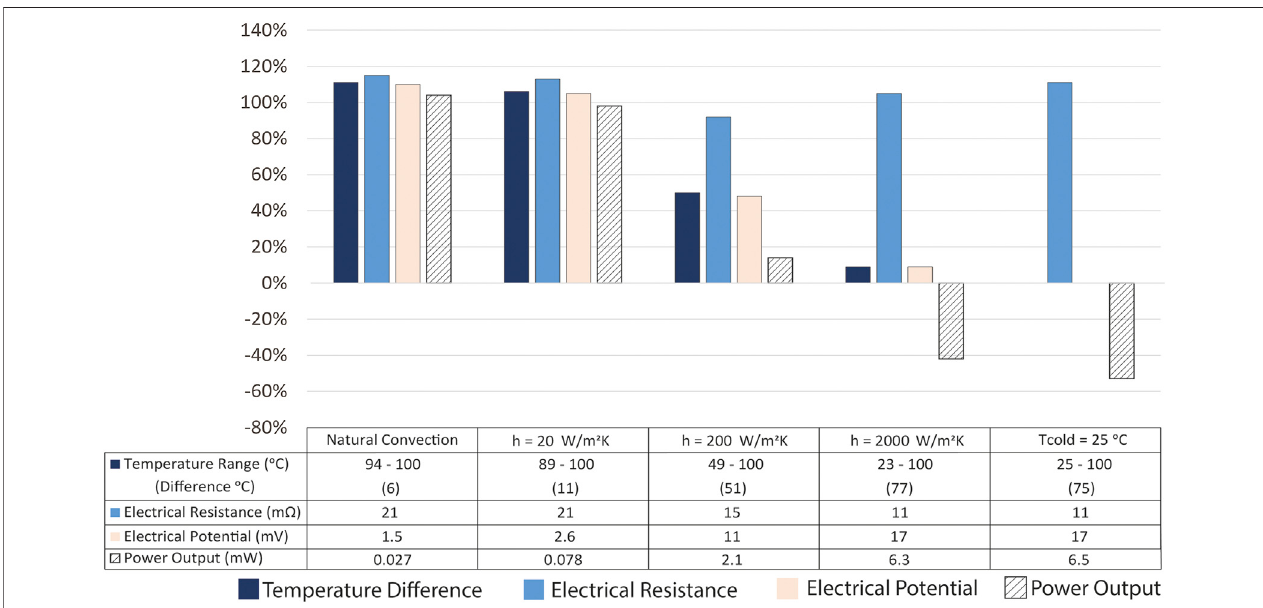
FIGURE 7 | The change in performance for the hourglass leg shape for various cold side boundary conditions (natural convection, forced convection coef fi cients h (cid:1) 20, 200, and 2,000 W/m 2 -K, and constant cold side temperatures T c (cid:1) 25, 300 C) and constant hot side temperature ( T h ). The percent change in the temperature range across the hourglass leg, leg electrical resistance and potential, and maximum power generation potential compared to those for a rectangular (conventional)